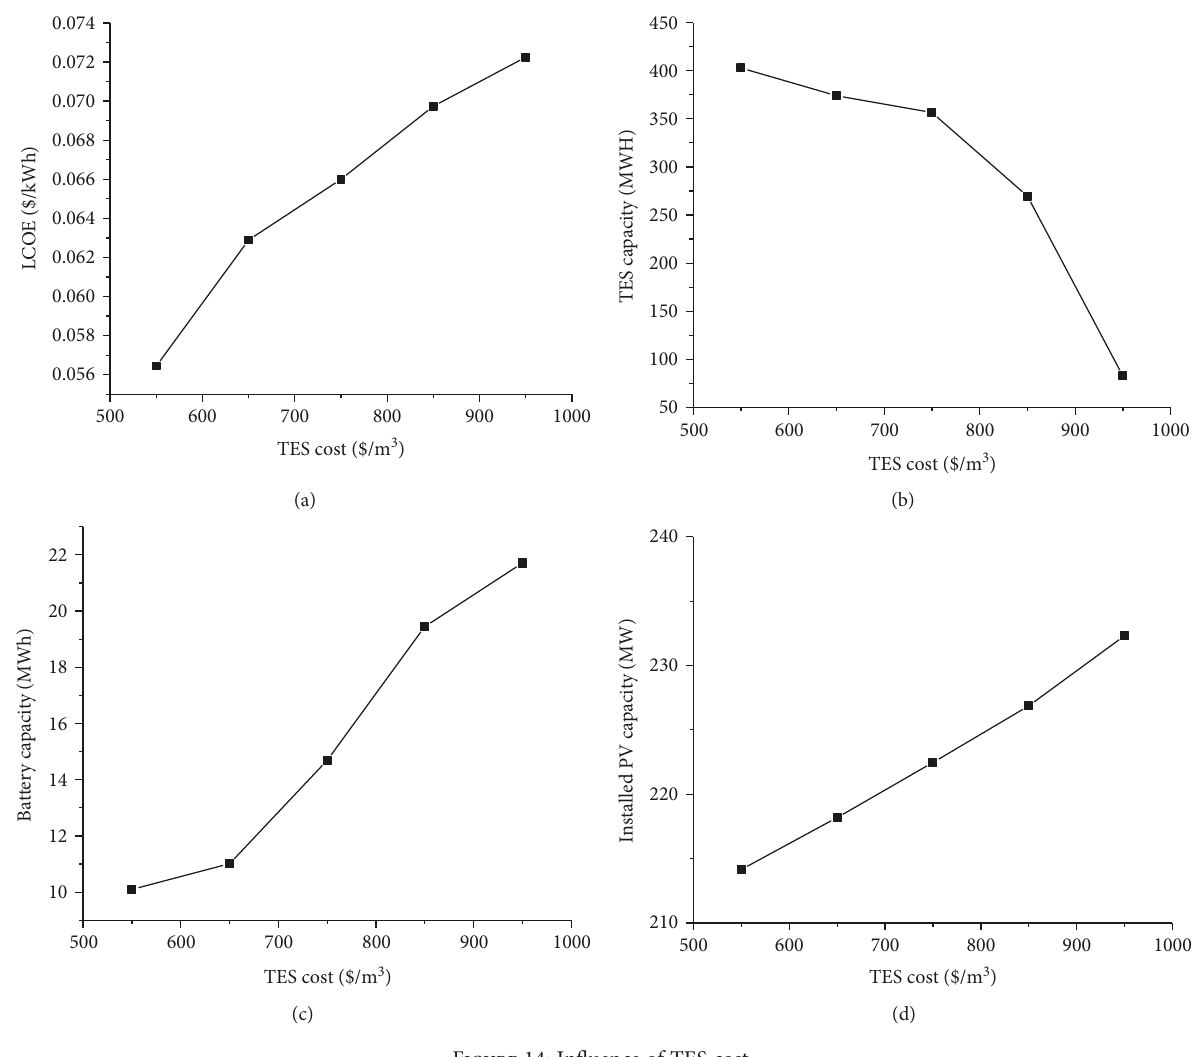
Figure 14: In fl uence of TES